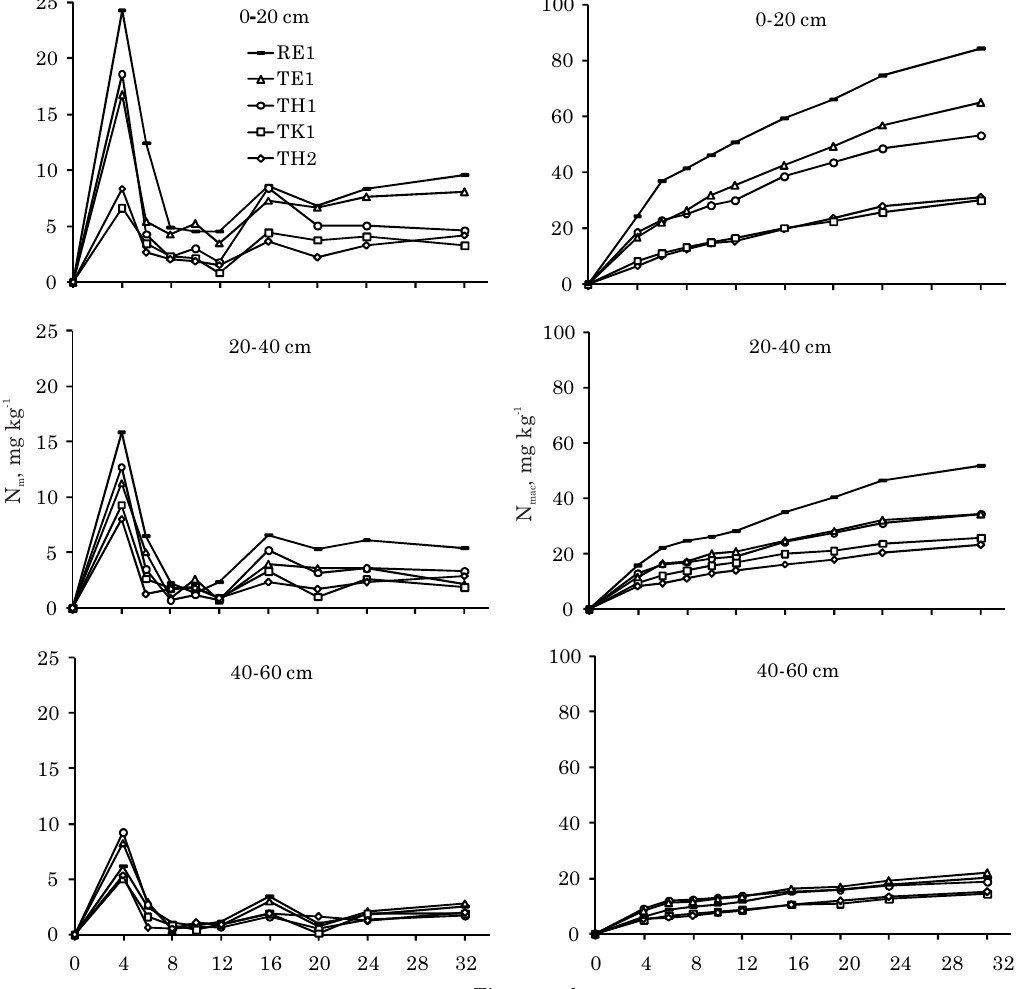
Figure 2. Mineralized nitrogen (N m ) and accumulated mineralized nitrogen (N mac ) in long-term aerobic incubation of soils (at three sampling depths) under